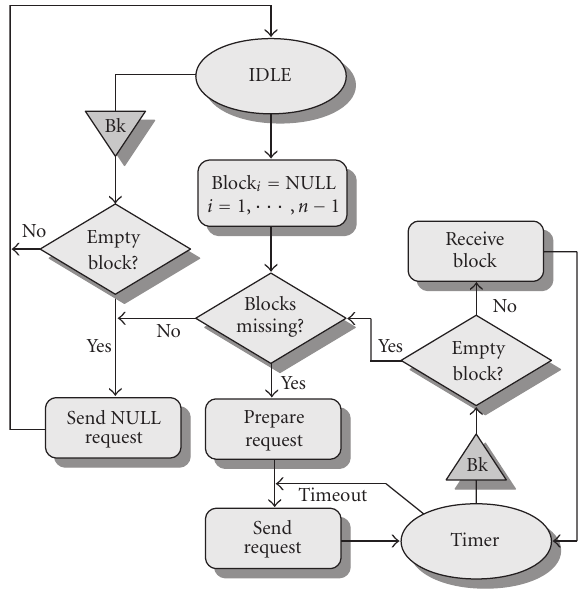
Figure 6: The reception part of the protocol.